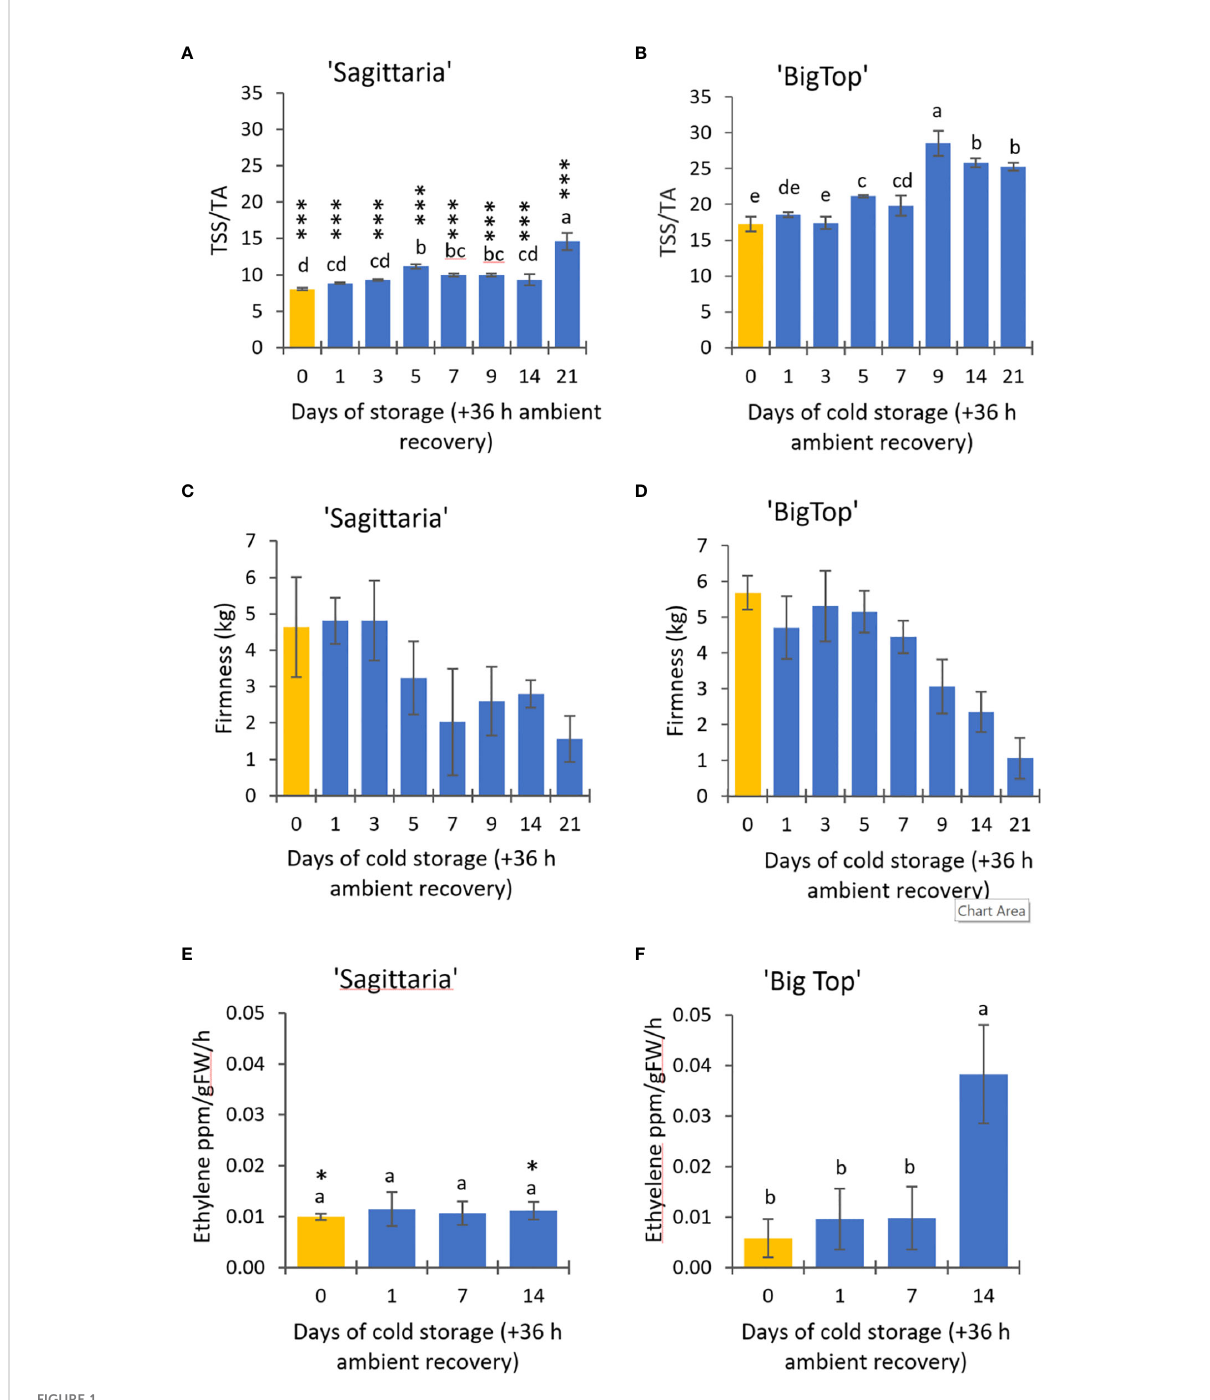
FIGURE 1 Effects of cold storage on ‘ Sagittaria ’ peaches and ‘ BigTop ’ nectarines at 1°C followed by 36 h recovery at ambient temperature (22 °C). (A, B) maturity index (total soluble solids/titratable acidity) (n=3); (C, D) fi rmness (kg) (n=10). (E, F) ethylene emission (n=6). Mean ± SD; letters indicate signi fi cant differences between time points based on ANOVA and Tukey ’ s rank test (P < 0.05). Asterisks indicate signi fi cant differences between ‘ Sagittaria ’ and ‘ Big Top ’ values for each day (*** <0.001, * <